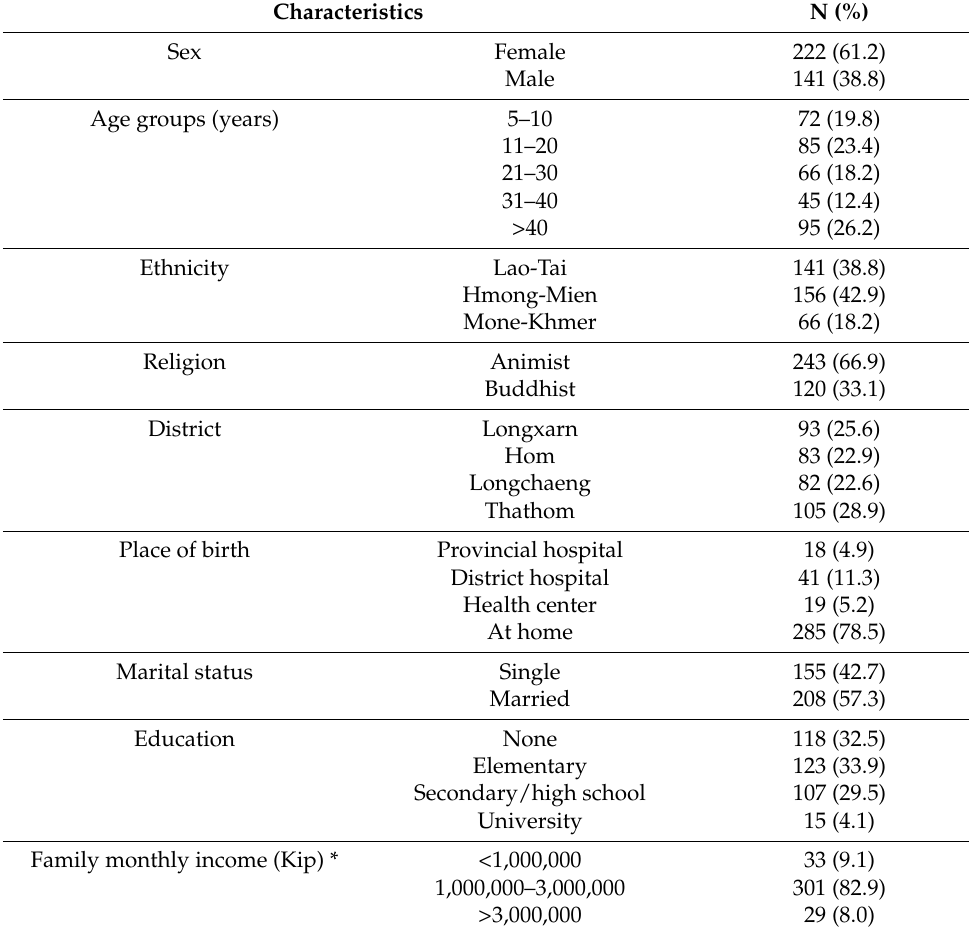
Table 1. Socio-demographic characteristics of study participants, Lao PDR ( n = 363).